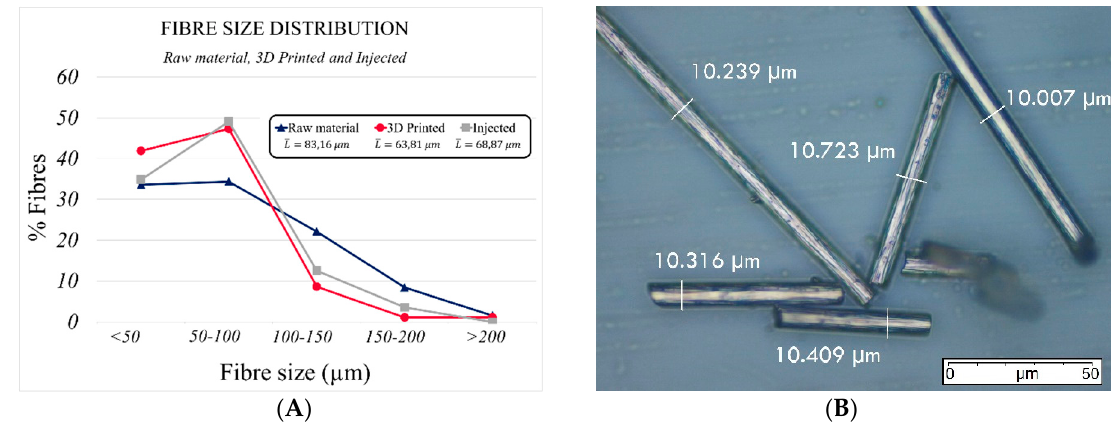
Figure 2. Results of the fibre length distribution in the raw material, injected and printed samples ( A ) and measurement of diameters in fibres using 400× with a microscope ( B ).